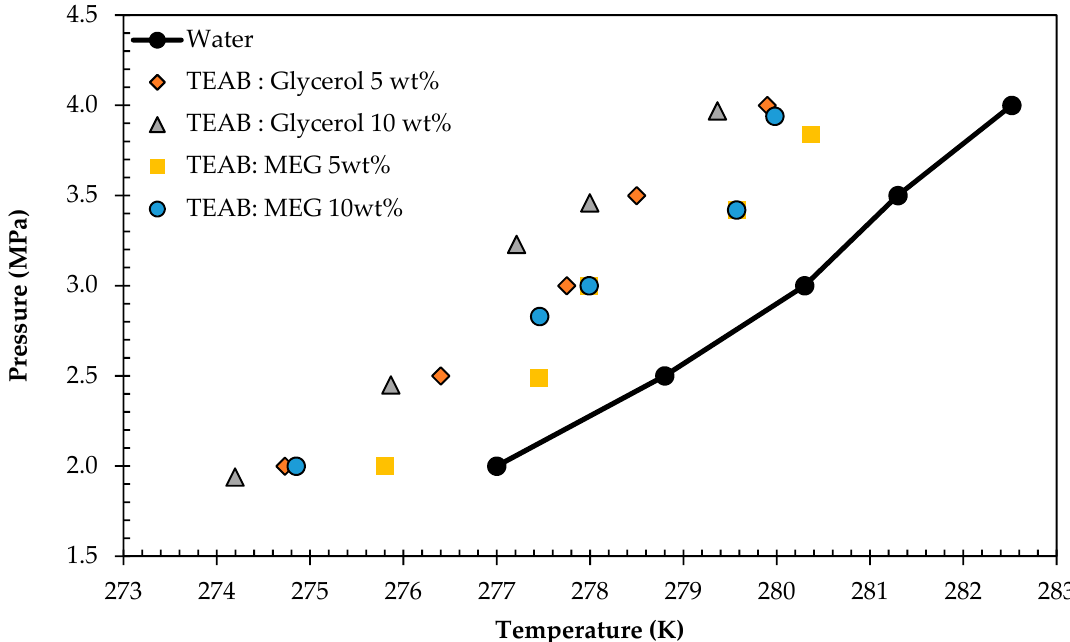
Figure 8. HLVE data of TEAB-based DES systems at five wt % and ten wt % concentrations. As the 10 wt % concentration of TEAB:Glycerol DES was showing good hydrate inhibition, and were made. Figure 9 displays the HLVE curve of THIs from the current work and literature.